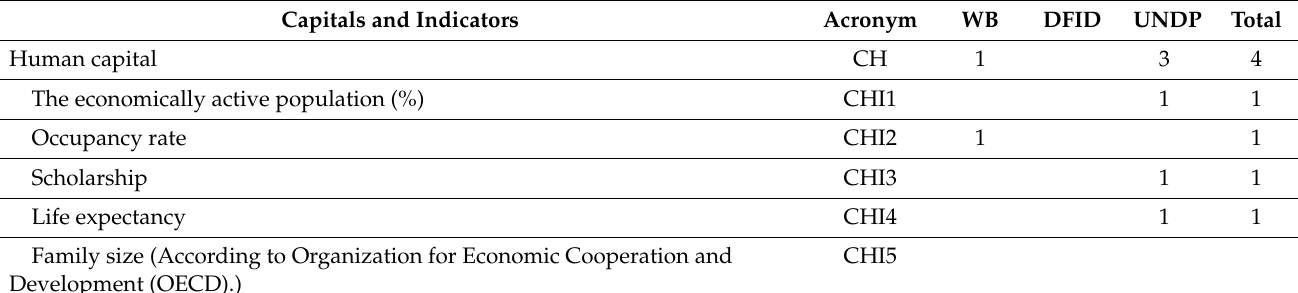
Table 1. Energy-related indicators, presented by Pereyra-Mariñez et al. (2022) [3]. Capitals and